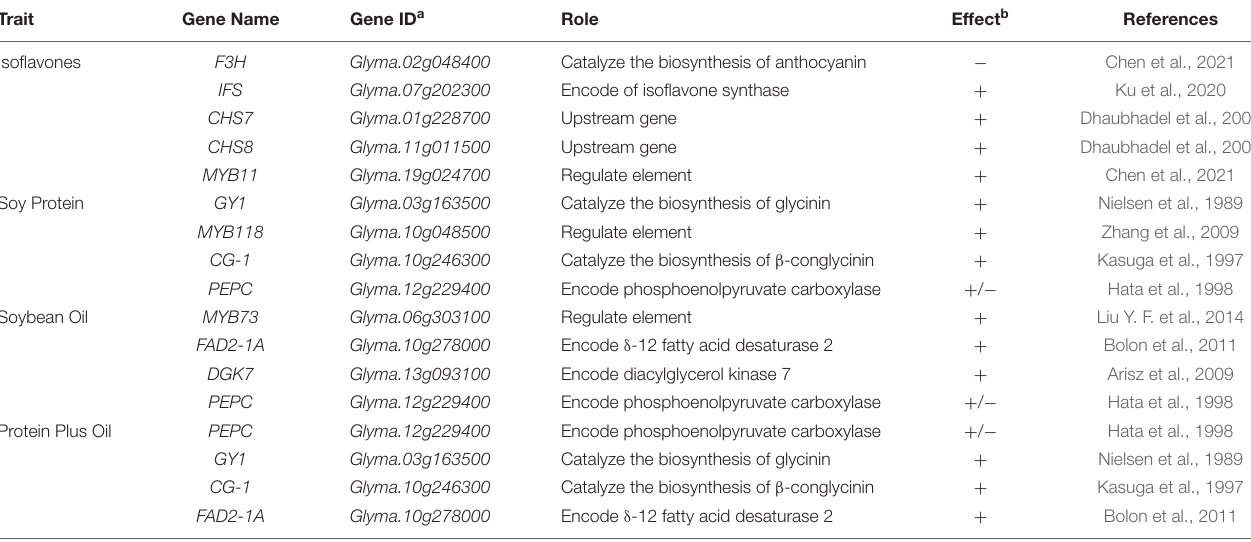
TABLE 2 | The effect of genes selected to characterize the accumulation of isoflavones, protein, and oil in soybean seed.